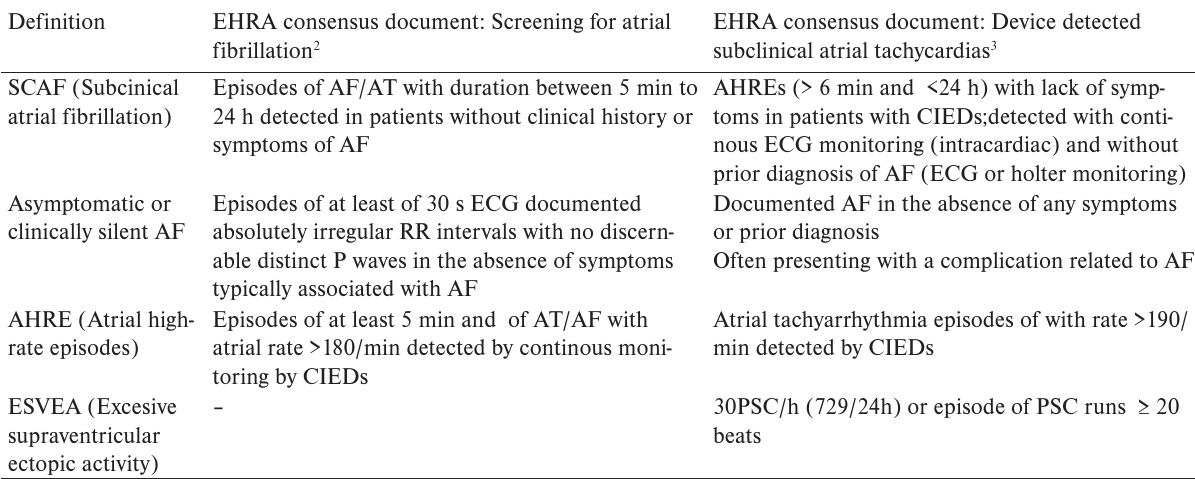
Table 1. EHRA consensus documents, subclinical atrial fibrillation terminology 2,3